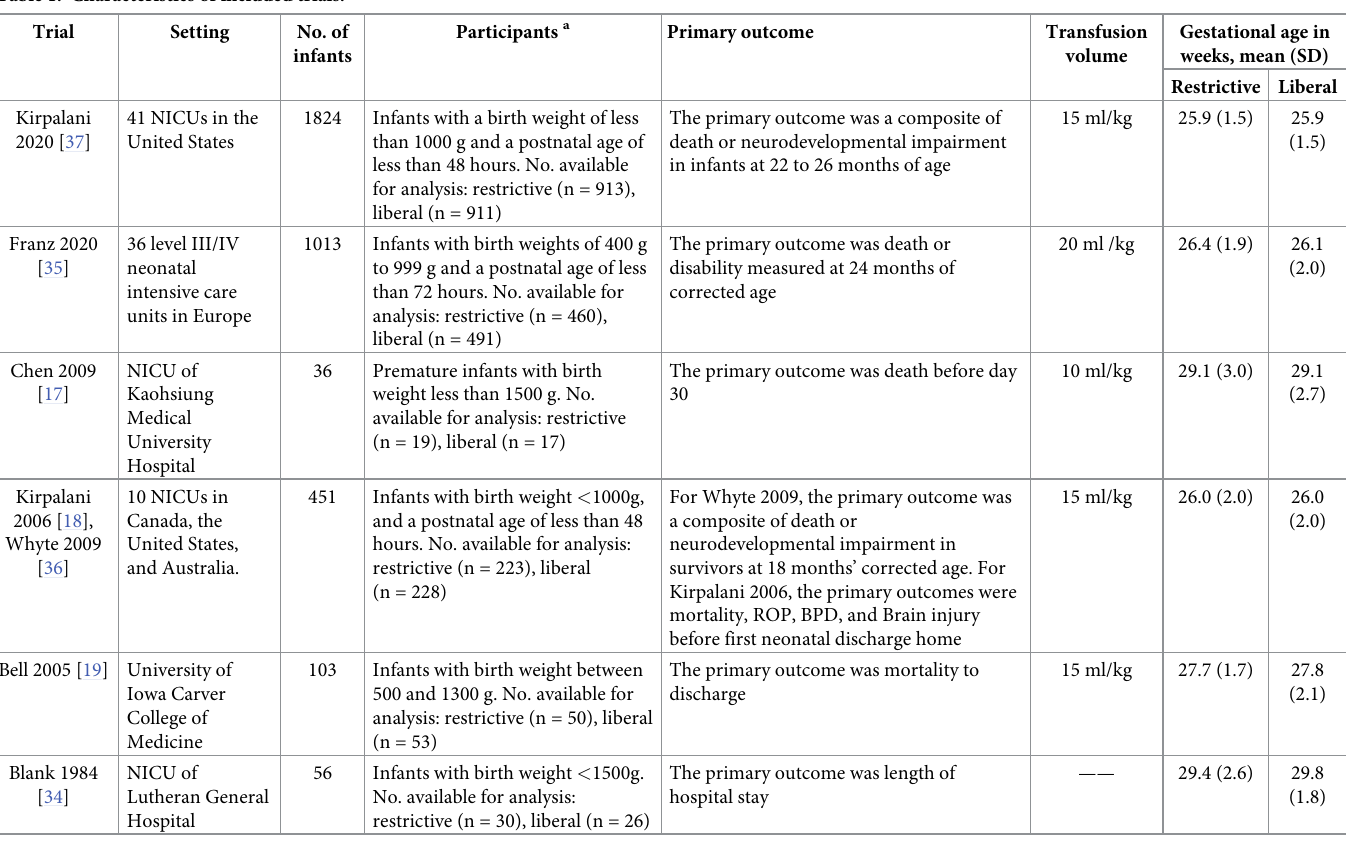
Table 1. Characteristics of included